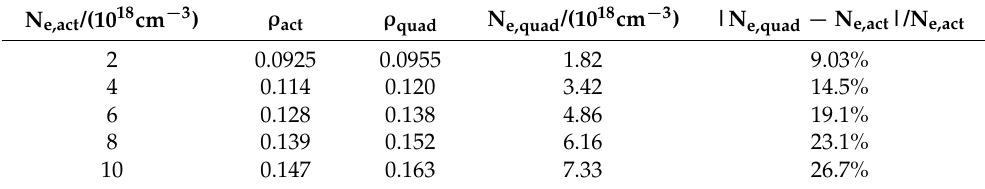
Table 4. The relative error in determining the electron density N e from the experimental asymmetry degree while disregarding the contribution of the penetrating ions for the He II Balmer-alpha line. The physical quantities in Table 4 are explained in the text directly above Table